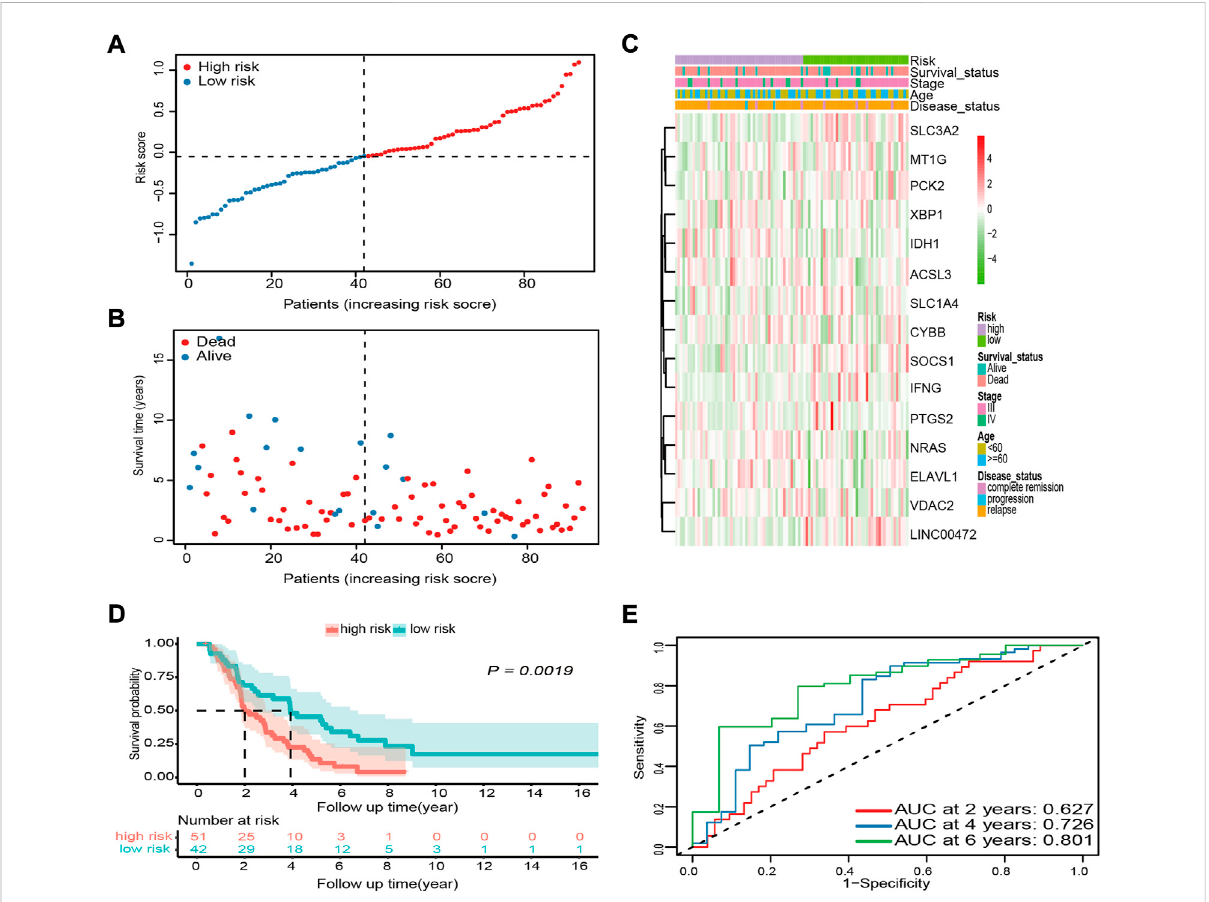
FIGURE 4 External validation of the prognostic performance of the 15-FRG signature in the ICGC cohort. (A) Distribution and median values of the risk scores. (B) Distributions of survival status, survival time, and risk score. (C) Distributions of risk score, clinical characteristics, and gene expression panels. (D) Kaplan – MeiercurvesforOSinthedifferentgroupsbasedonthecut-offpointdeterminedfortheGSE32062cohort. (E) Time-dependent ROCcurvesandtheirAUCs.FRG,ferroptosis-relatedgene;ICGC,InternationalCancerGenomeConsortium;OS,overallsurvival;ROC,receiver operating characteristic; AUC, area under the